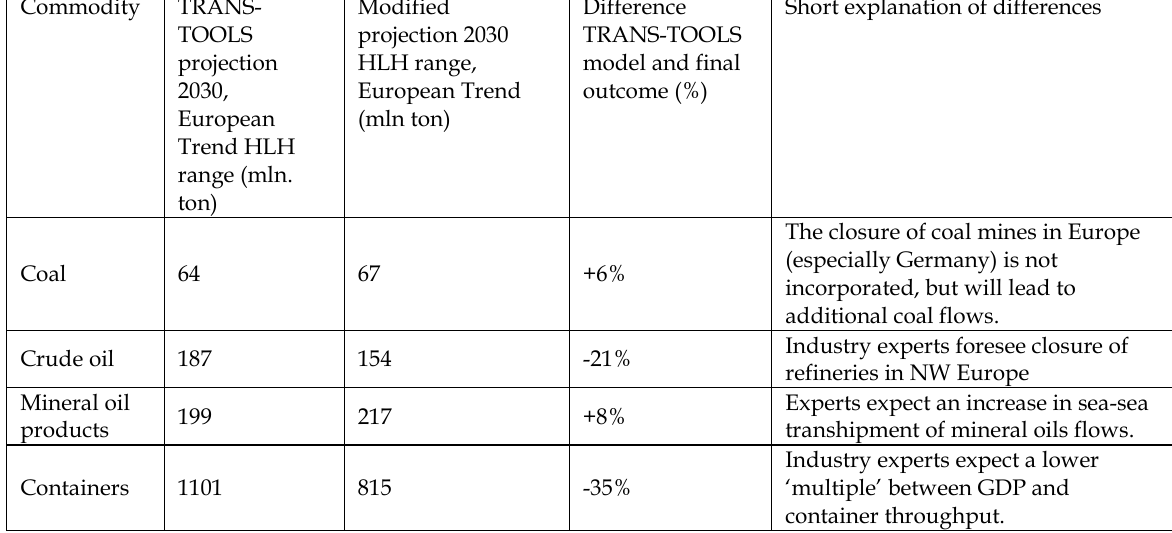
Table 5. Differences between TRANS-TOOLS model results and final projection, for the